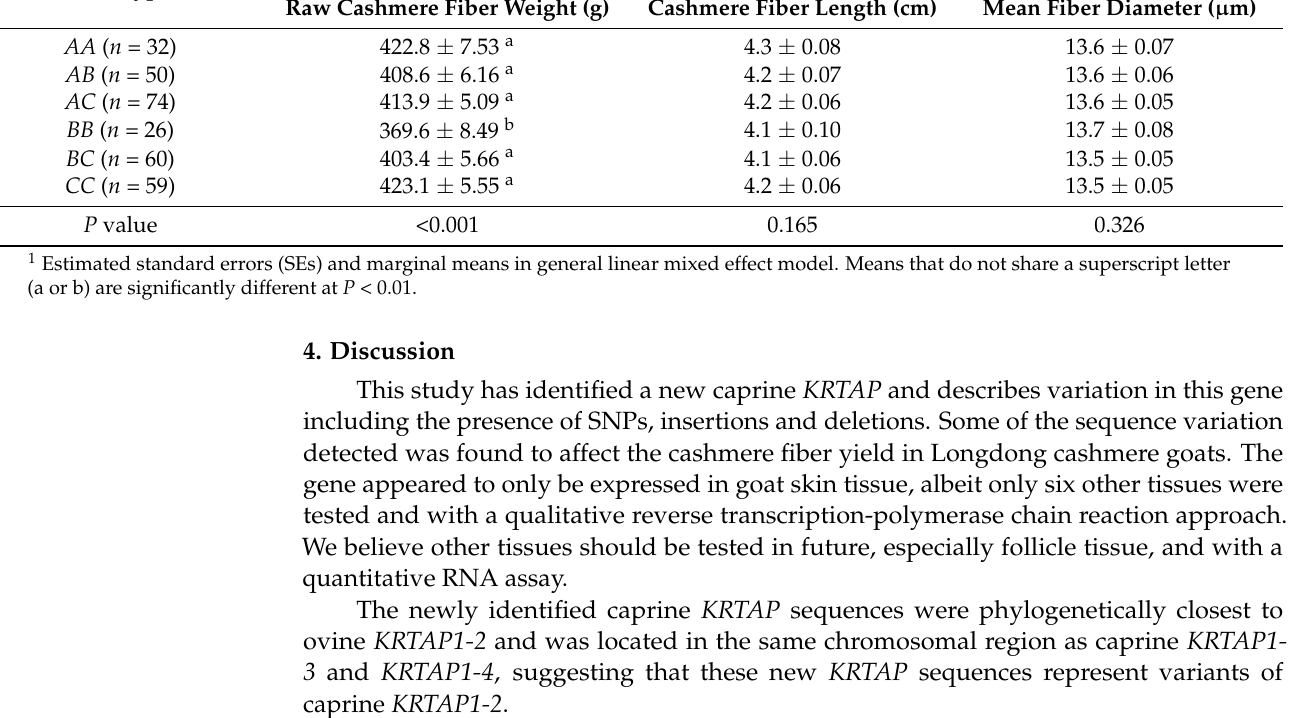
Table 2. Association between caprine KRTAP1-2 genotypes and cashmere fiber traits.